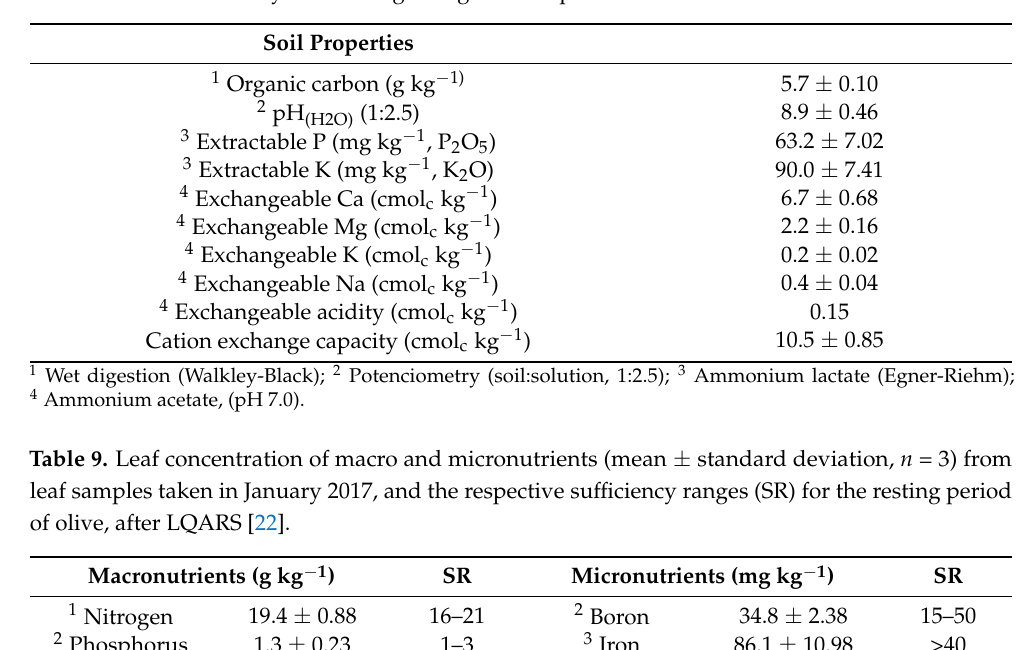
Table 8. Selected soil properties from composite samples (10 cores per composite sample, n = 3) taken from the 0–0.20 m soil layer at the beginning of the experiment.